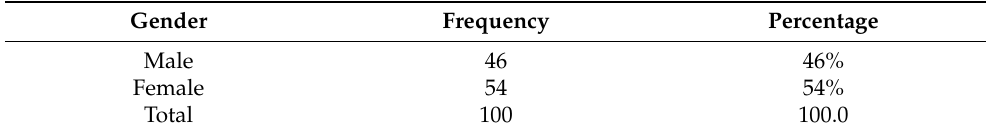
Table 5. Gender frequency of respondents.